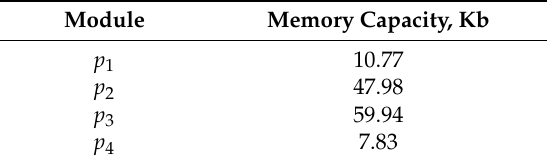
Table 4. The required amount of memory for storing the values of the intermediate samples.